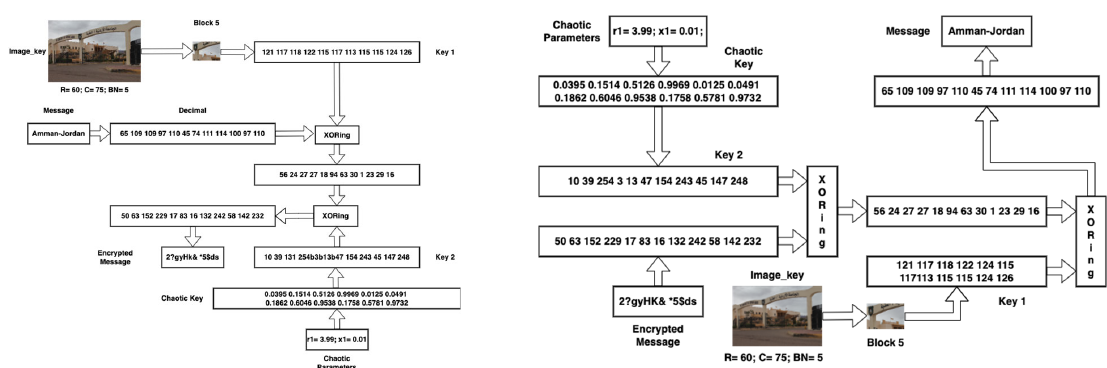
Fig. 11 . The proposed approach